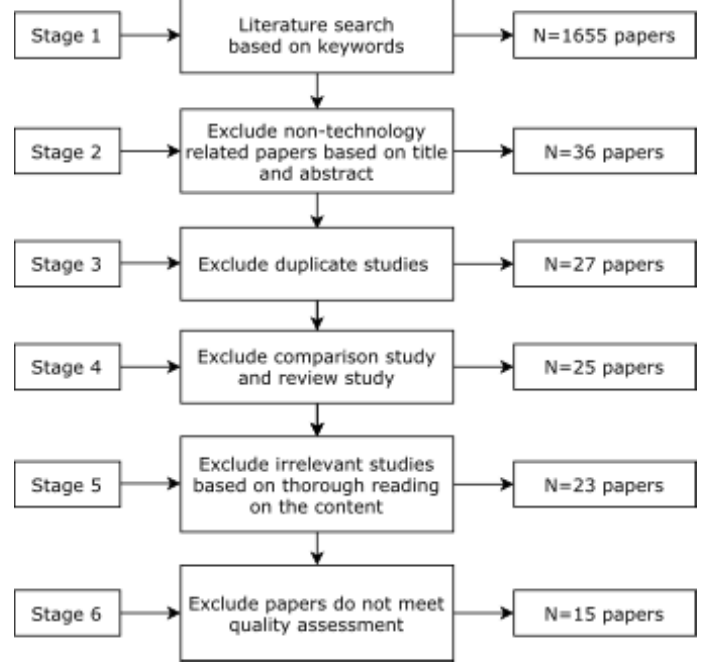
Figure 2. Stages of primary studies search